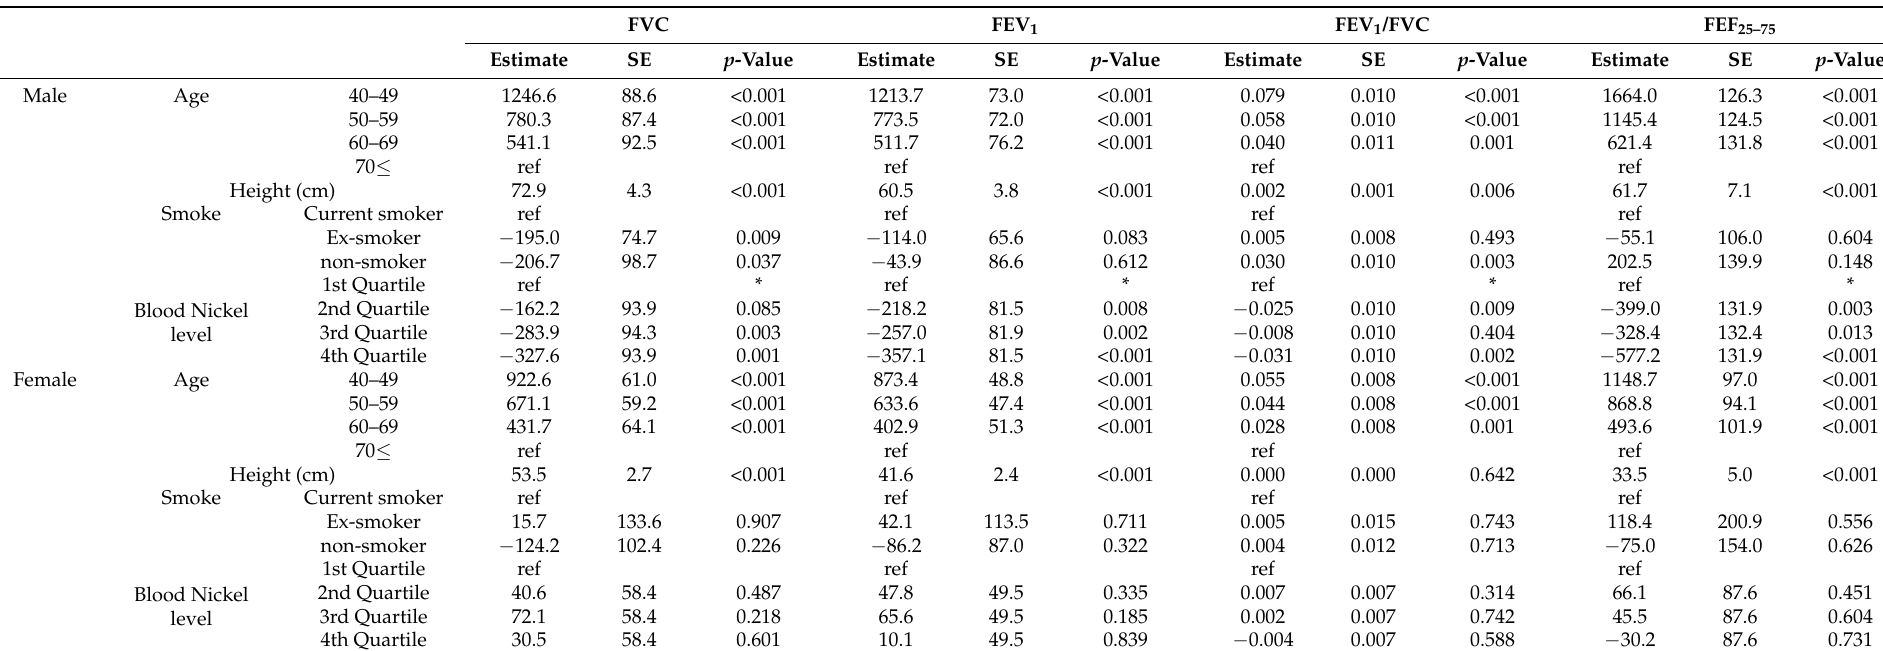
Table 3. Univariate analysis of independent variables, including blood nickel concentration, affecting pulmonary function components by